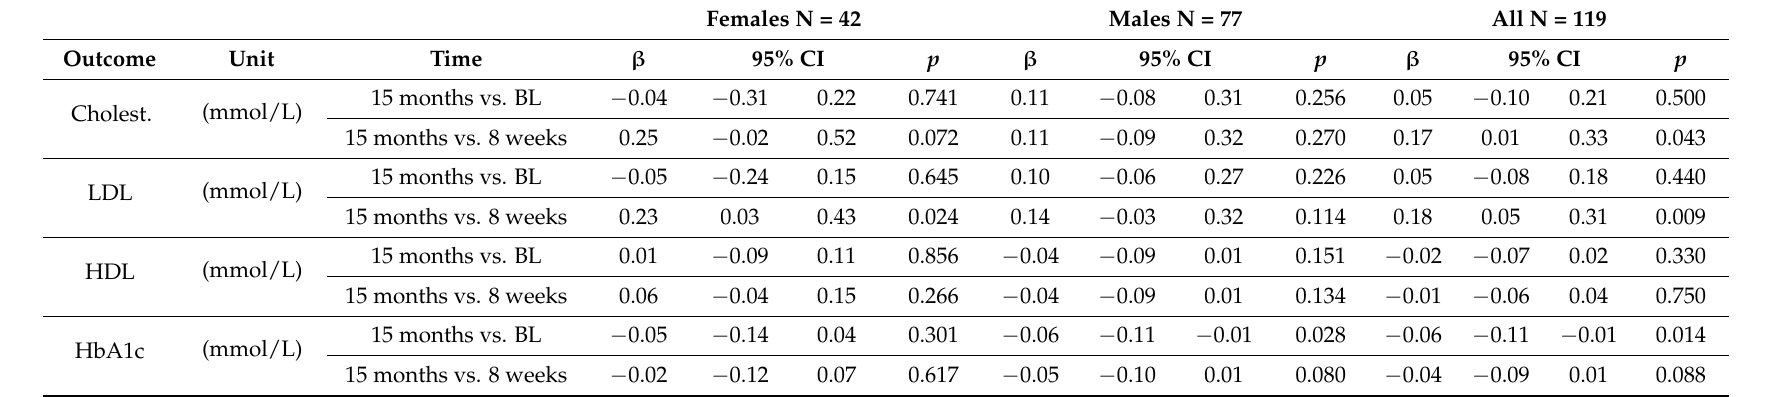
Table 3. Cholesterol, LDL, HDL, and